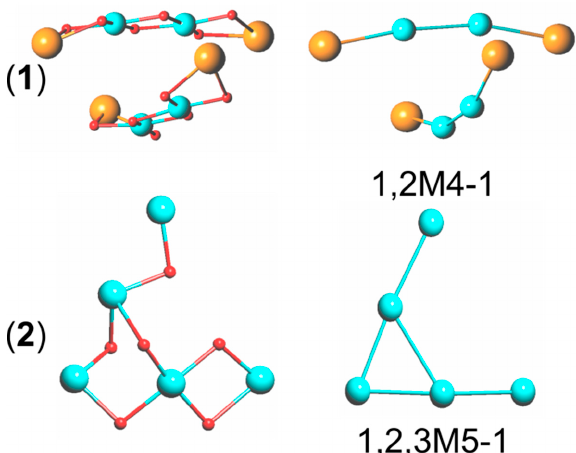
Figure 3. The Cu-containing polynuclear complexes in 1 and 2 connected by the bridged atoms (left) and the graphs for the corresponding polynuclear complexes’ connectivity (right). Color code: Cu—blue, Na—orange and O—red.